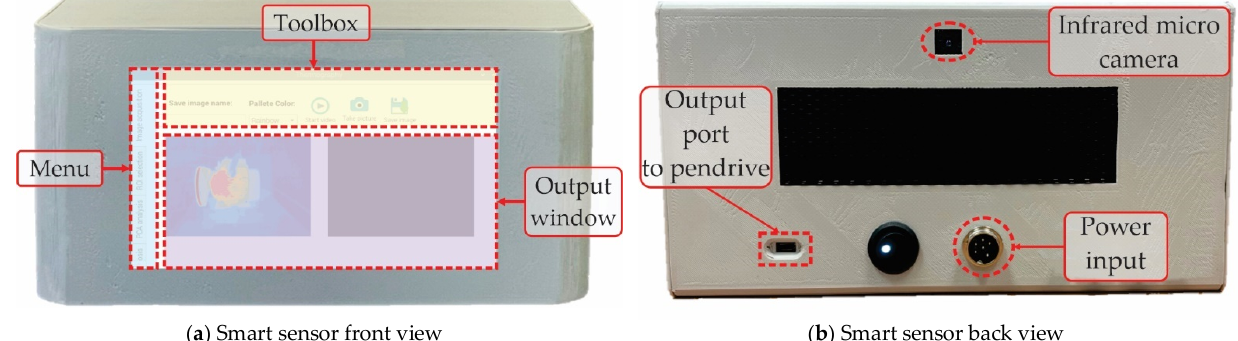
Figure 11. Smart sensor based on infrared thermography, physical system in ( a ) front view and in ( b ) back view.